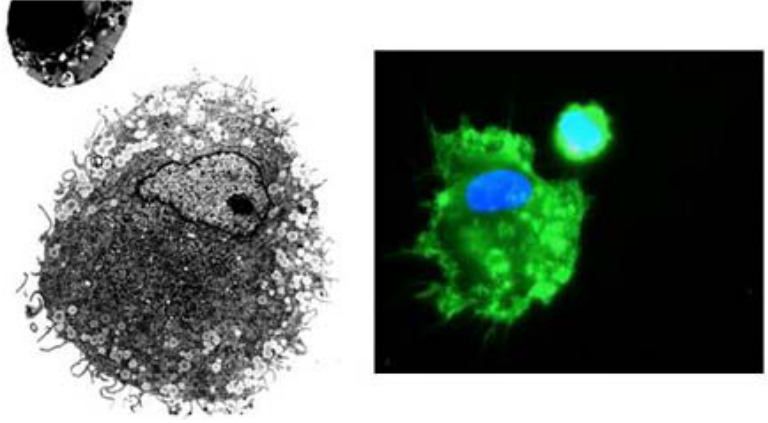
FIGURE 4. LXA 4 primes human monocyte-derived M φ to phagocytose apoptotic PMNs. M φ were treated with LXA 4 (1 nM for 15 min) before coincubation with aged PMNs for 30 min. Cells were fixed and processed for electron microscopy or immunofluorescence. Actin is visualized by staining with Oregon Green